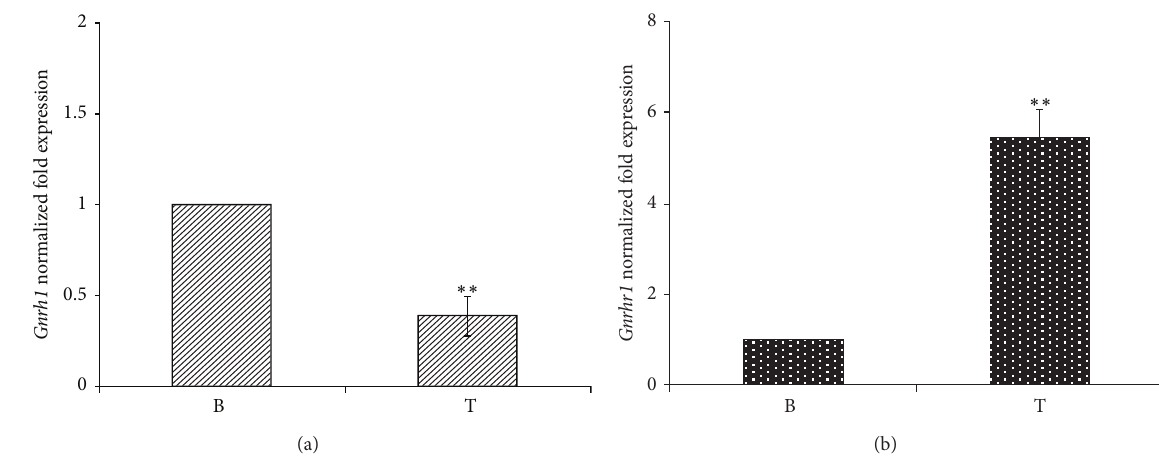
Figure 1: Gnrh1 (a) and Gnrhr1 (b) expression by qPCR in R. norvegicus tissues. B, brain; T, testis. Data are reported as mean fold change ± SD over the value one arbitrarily assigned to brain sample. Asterisks indicate statistically significant differences ( 𝑃 < 0.01 ), and data are representative of three separate experiments at least ( 𝑛 = 6